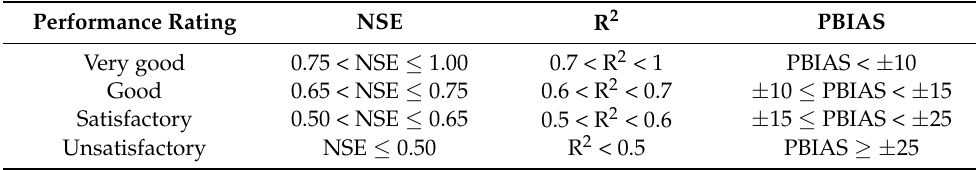
Table 1. Performance rating of NSE, R 2 , and PBIAS values for river discharge [42–44]. Performance